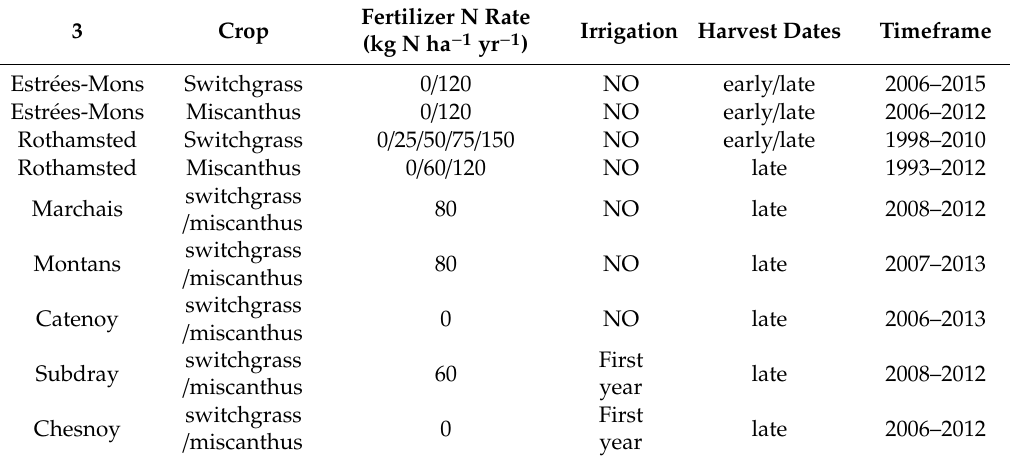
Table 1. Crop management characteristics for the experimental sites used for model calibration and